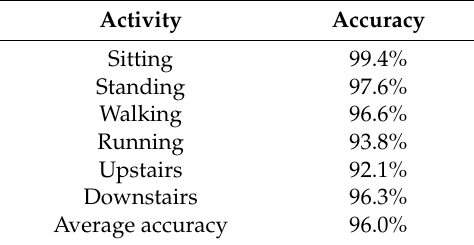
Table 4. The performance of H-SVM and Context-based classification (HSVMCC).